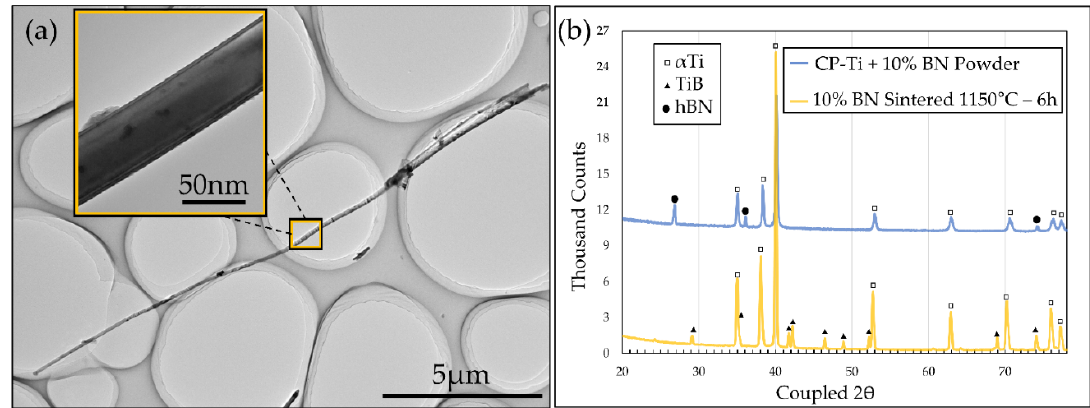
Figure 2. ( a ) TEM image showing a nanowhisker extracted from 10% BN sample after sintering at 1050 °C for 6 h, with inset high magnification image for measuring whisker diameter; ( b ) XRD pattern of 10% BN powder before sintering and after sintering at 1150 °C for 6 h.